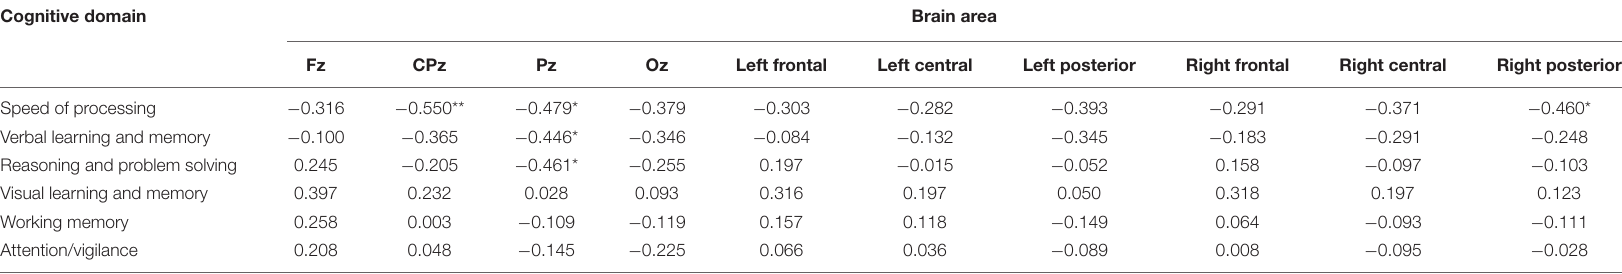
TABLE 5 | Relationship between theta relative power and MCCB domains scores with eyes open in schizophrenia. Cognitive domain